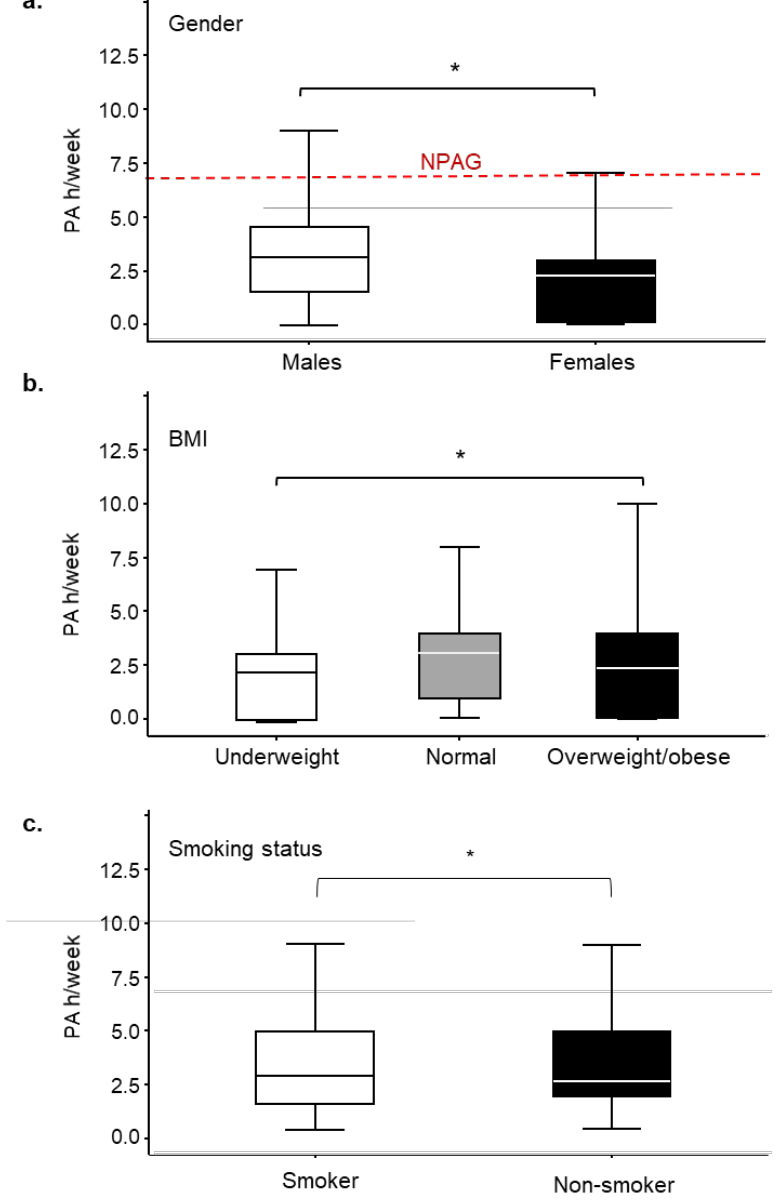
Figure 1. The relationship between the levels of physical activity and gender, body mass index (BMI) or smoking status in 16 – 18-year-old adolescents ( n = 414). ( a ) Differences of physical activity levels between males [mean (standard deviation (SD)): 3.23 (2.70), n = 200] and females [mean (SD): 2.27 (2.62), n = 214]; ( b ) Differences of physical activity levels between BMI categories [mean (SD): underweight 2.18 (2.60), normal 3.00 (2.95), overweight/obese 2.30 (2.42)]; and ( c ) Differences of physical activity levels between smokers [mean (SD): 2.8 (2.83)] and non-smokers [mean (SD): 2.6 (2.55)]. Red dashed line indicates the UK National Physical Activity Guidelines (NPAG) recommended for those between the ages of 5 to 18 years old. Gender * p -value 0.0216, odds ratio (OR) 0.61 (0.404, 0.930); BMI (normal and overweight / obese) * p -value 0.0038, OR 2.15 (0.951, 4.854); smoking * p -value 0.0413, OR 1.82 (1.025,